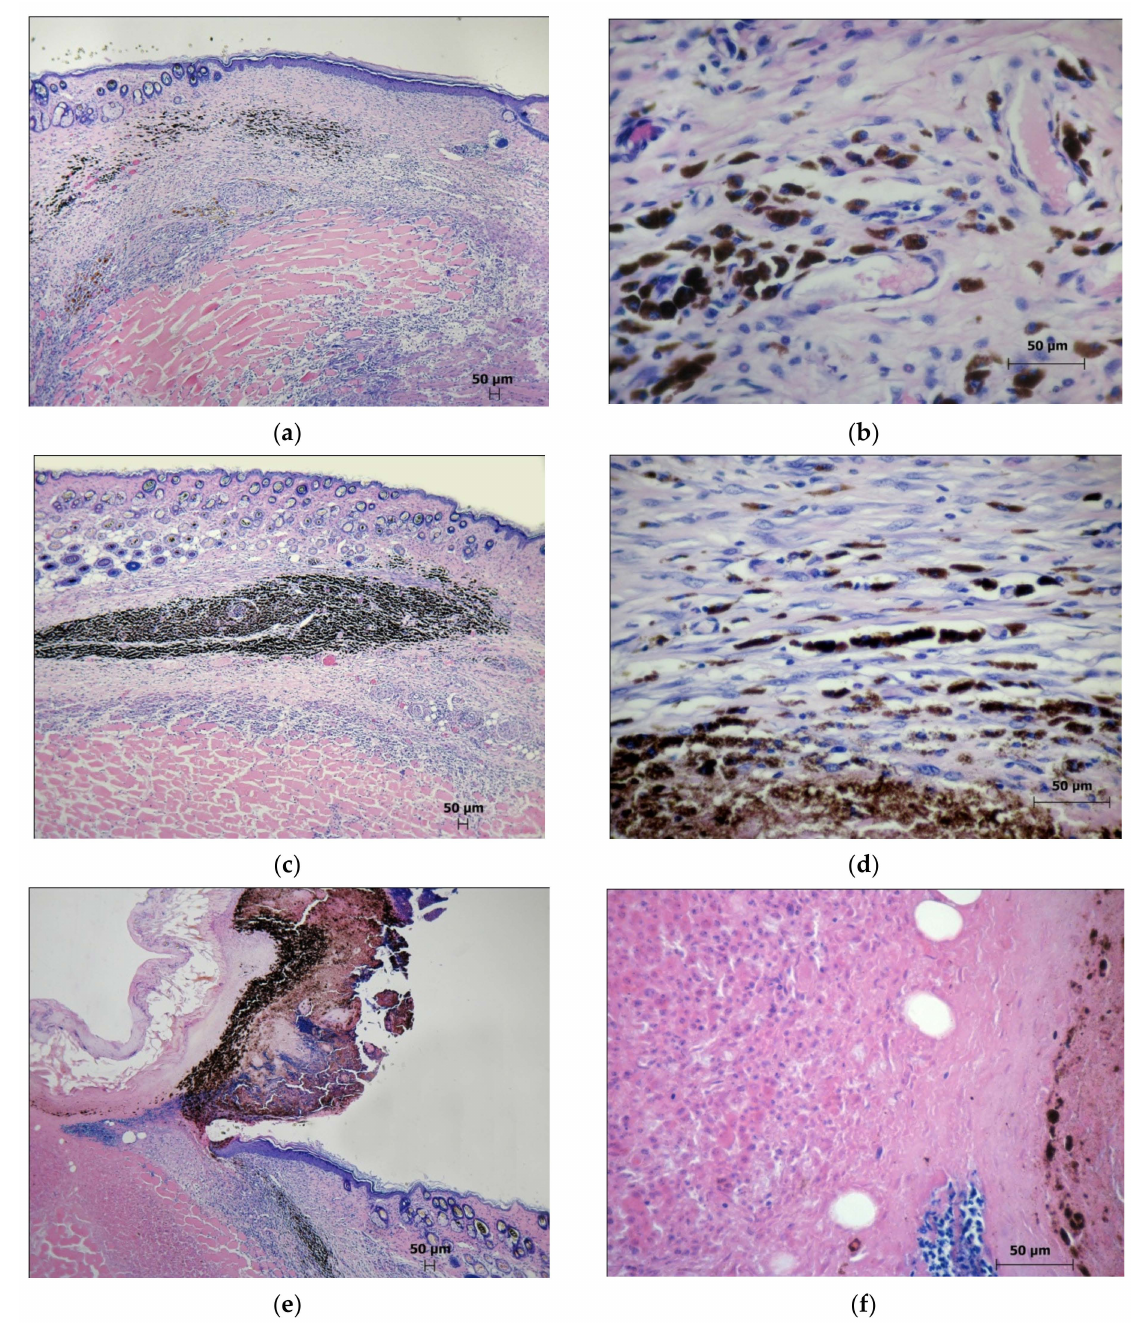
Figure 7. The zone of the laser exposure on the 21st day after the PDT. Experimental group 3: ( a ) Epithelialization of the zone of the photodynamic exposure and destruction of the muscle tissue. Staining with hematoxylin and eosin. × 5; ( b ) The melanin-containing macrophages at the site of an eliminated tumor in the zone of the photodynamic exposure. × 40; ( c ) The melanophages eliminating tumor detritus. Staining with hematoxylin and eosin. × 5; ( d ) An accumulation of the melanophages around the dilated lymphatic capillaries and in their lumen. Staining with hematoxylin and eosin. × 40; ( e ) A rejection of a part of the tumor eliminated by the macrophages in the composition of a scab. Fragment. Staining with hematoxylin and eosin. × 5; ( f ) Fragment. Histostructure of a necrotic tumor. Staining with hematoxylin and eosin. ×